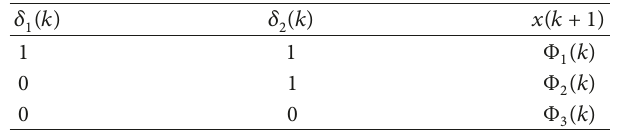
Table 3: The relationship between 𝛿 1 (𝑘) , 𝛿 2 (𝑘) , and 𝑥(𝑘 + 1)